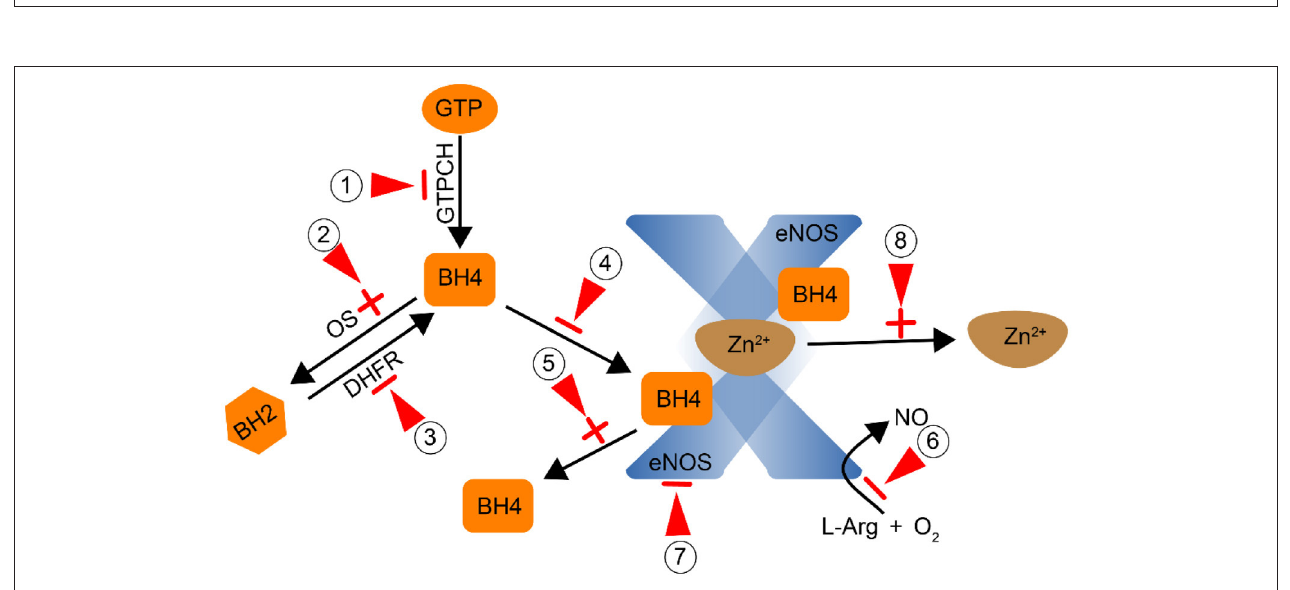
FIGURE 4 | Smoking affects the activity of eNOS by direct or indirect action (Red arrow: point of action). 1 Inhibit GTPCH and reduce the synthesis of BH4; 2 Promote the conversion of BH4 to BH2 through oxidative stress; 3 Inhibit DHFR and reduce the conversion of BH2 to BH4; 4 , 5 Prevent the combination of BH4 and eNOS to form a stable dimer; 6 Inhibit the conversion of L-Arg to NO; 7 Inhibit the activity of eNOS; 8 Promote the dissociation of Zn 2 + from the dimer.